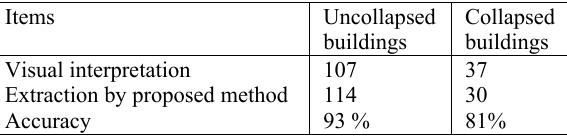
Table 1. The accuracy test